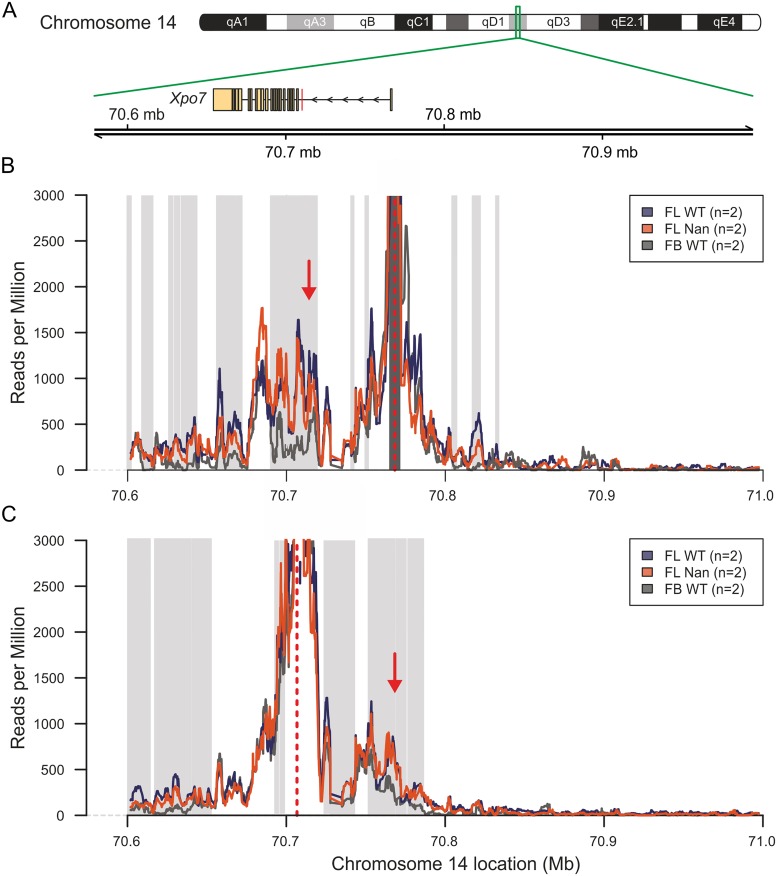
4C-seq analysis of the Xpo7 locus.(A) Schematic representation of chromosome number 14. The green box indicates the zone where the Xpo7 gene resides. The RefSeq mm10 Xpo7 gene is indicated by rectangles (exons) and arrows (introns) that point to the direction of transcription. The location is indicated in Mega basepairs (Mb). The erythroid-specific first exon is indicated by a red box. (B-C) 4C-seq representation of the chromosome contact frequencies detected using the canonical promoter of Xpo7 (B) and the region of the erythroid specific Xpo7 exon (C) as viewpoints. The mean of a running windows of 21 restriction fragment-ends of the median value of the biological replicates with a maximum of 3000 are indicated by colored lines. Loci with a statistically significant (FDR <0.05) higher contact frequencies and reads per million >250 in wildtype fetal liver compared to the fetal brain are indicated by light grey boxes. Loci with a statistically significant (FDR <0.05) higher contact frequencies and reads per million >250 in fetal brain compared to the wildtype fetal liver brain are indicated by dark grey boxes. The red dotted line indicates the view point and the red arrow the position of the loop. Purple, wildtype fetal liver; Orange, Nan fetal liver; Grey, wildtype fetal brain.